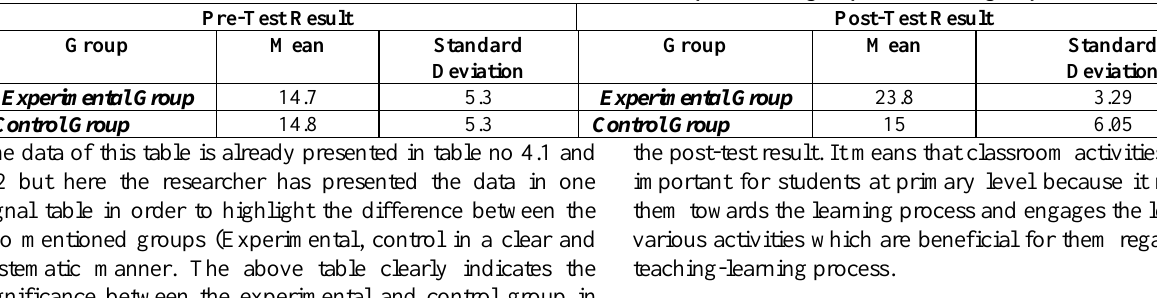
Table No 4.3: Pre-test and Post-test results of both experimental group and control group